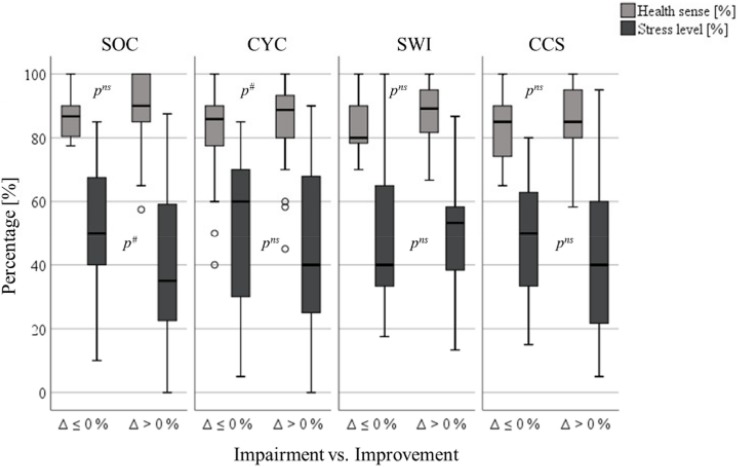
Sport-specific health senses and stress levels dependent on performance development. Δ = delta Paerob V1 vs. Paerob V2; SOC, soccer; CYC, cycling; SWI, swimming; CCS, cross-country skiing. #p < 0.05, nsp ≥ 0.05 (non-significant).